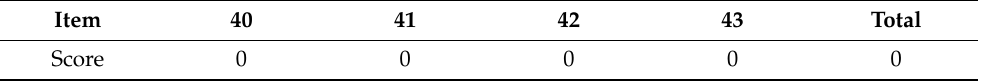
Table 9. Anna’s scores on the four items of the subcomponent Antisocial Pattern